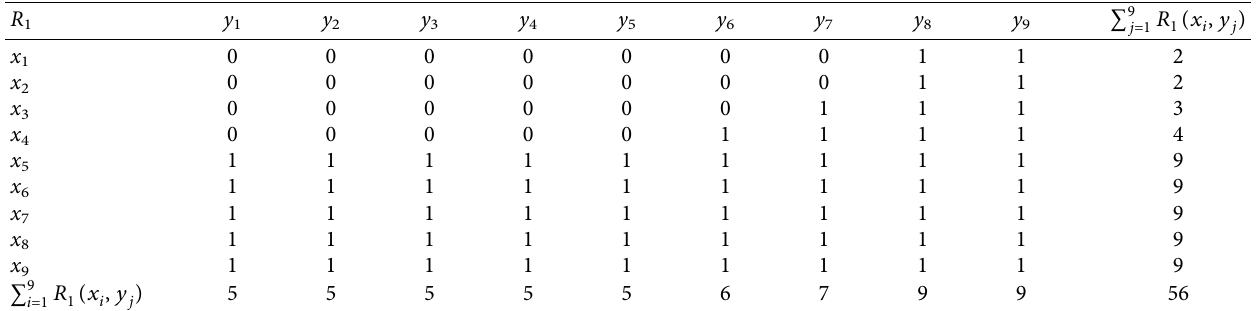
Table 2: The value of R